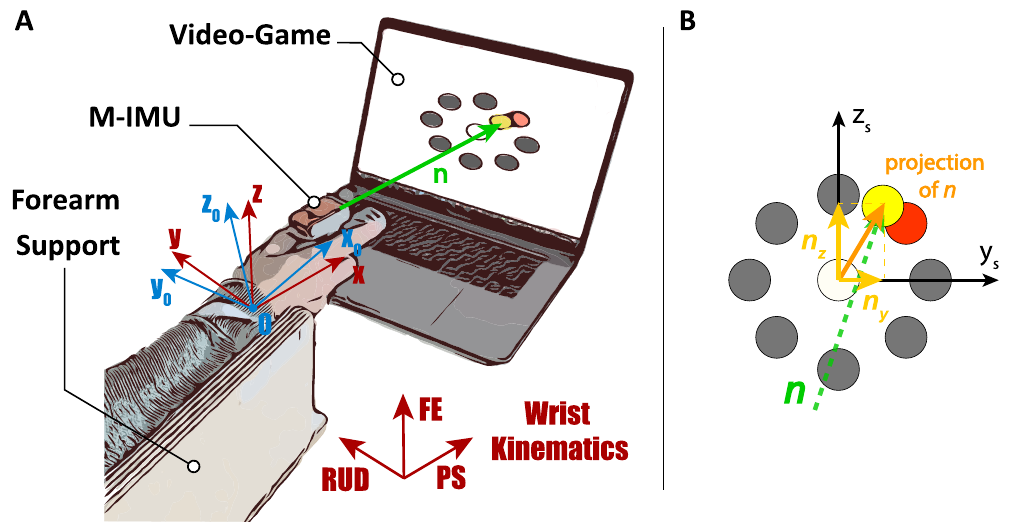
Figure 7. ( A ) Overview of the experimental setup. For details on wrist kinematics refer to 8 . The blue reference frame “0”, centered in the wrist center of rotation, refers to the neutral position of the wrist- zero position - and corresponds to the initial position; the red reference frame represents the current wrist orientation recorded by the M-IMU. ( B ) Scheme of the clock-like game with the 2D projection of the pointing vector n onto the screen reference frame { y s , z s }